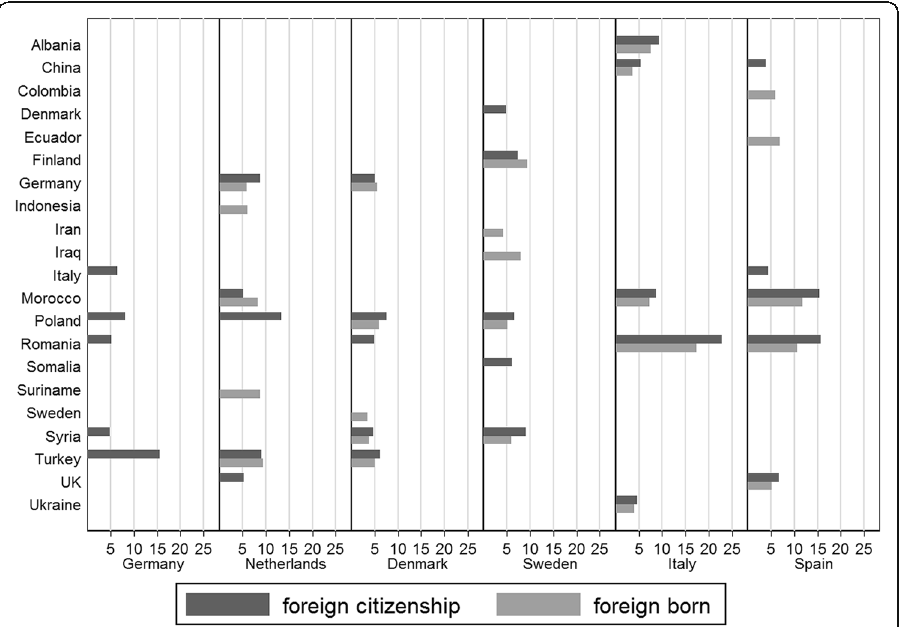
Fig. 5 Main countries of citizenship & birth of the foreign/foreign-born population (1 January 2016, per cent). Notes : The graph shows for each country of our country sample the five largest immigrant groups as a percentage of the total foreign population in the country (black bars) and the five largest immigrant groups as a percentage of the foreign-born population in the country (grey bars; except for Germany). Eurostat (online data codes: migr_pop1ctz and